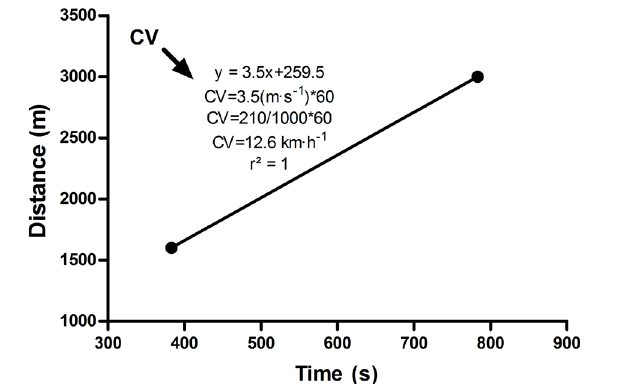
Figure 2. Example of critical velocity (CV) determination using the distance-time linear model for the participant#1 (CV= 12.6 km·h -1